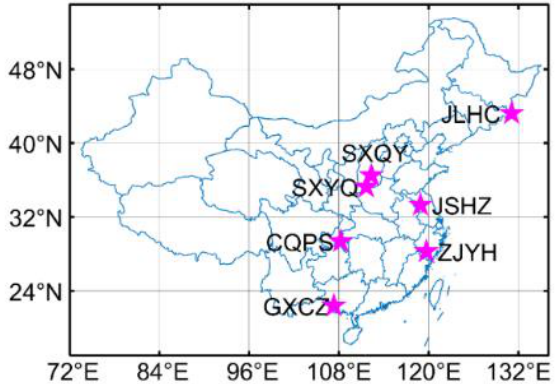
Figure 1. Main procedures flow chart to establish the LSTM-ZTD forecast model.